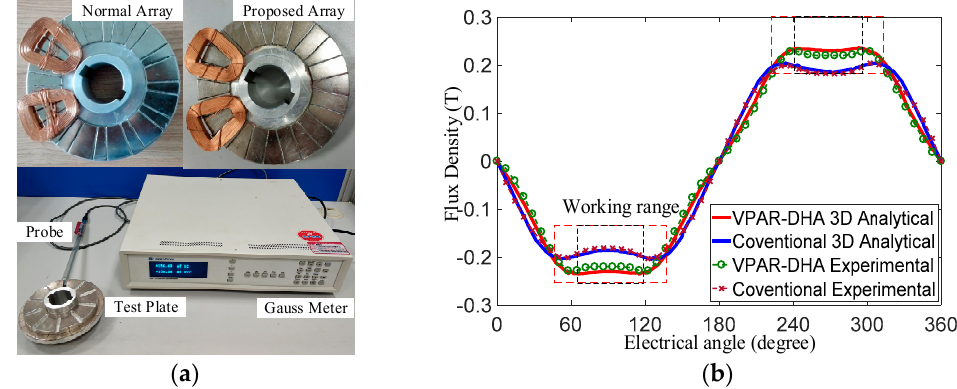
Figure 14. Experiments on flux density: ( a ) Halbach arrays; ( b ) Comparison of the analytical and experimental results.